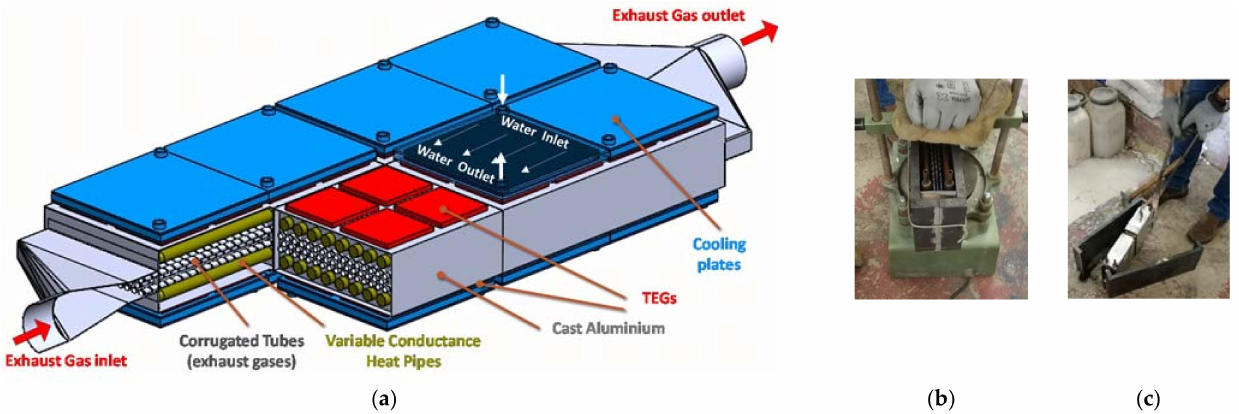
Figure 12. ( a ) Global CAD drawing of the TEG generator concept incorporating helically corrugated pipes for the exhaust flow and heat and VC HPs in gold, with the cooling water plates in blue, the TEG modules in red; partial prototype under construction ( b ) prior and ( c ) after casting